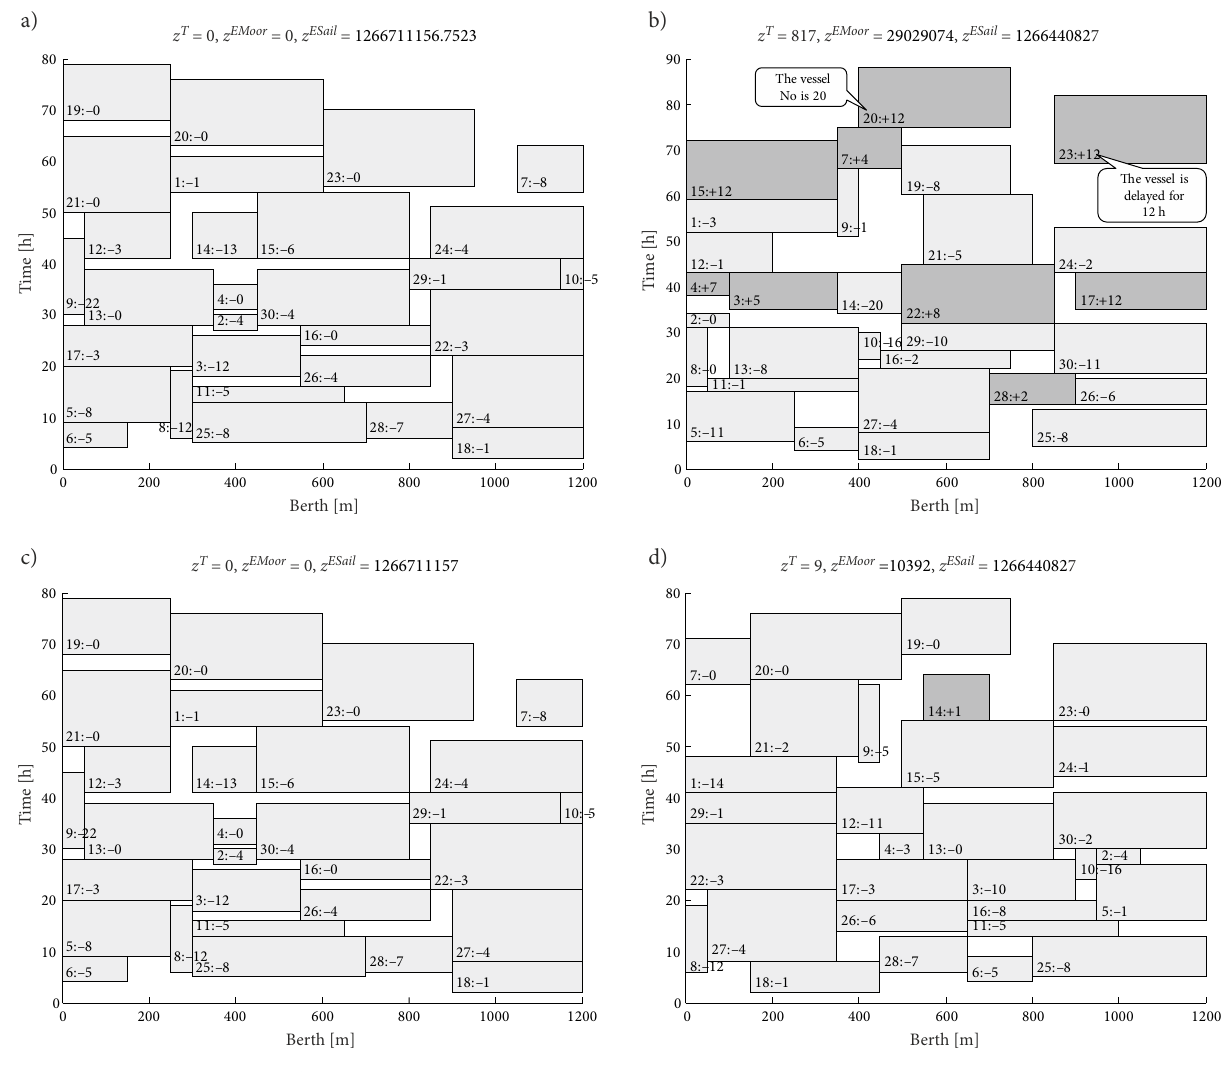
Figure 3. The schedules of solely minimizing one of four objectives: a – weighted delay time; b – sailing emission; c – mooring emission; d – emission